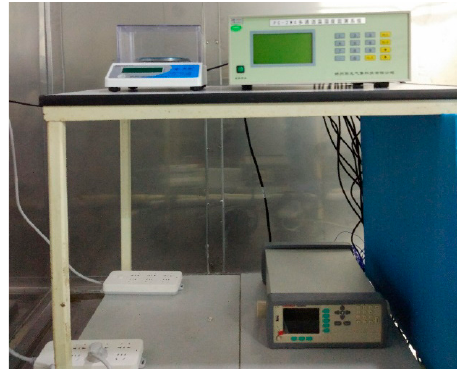
Figure 5. Image of the cold water supplying system.